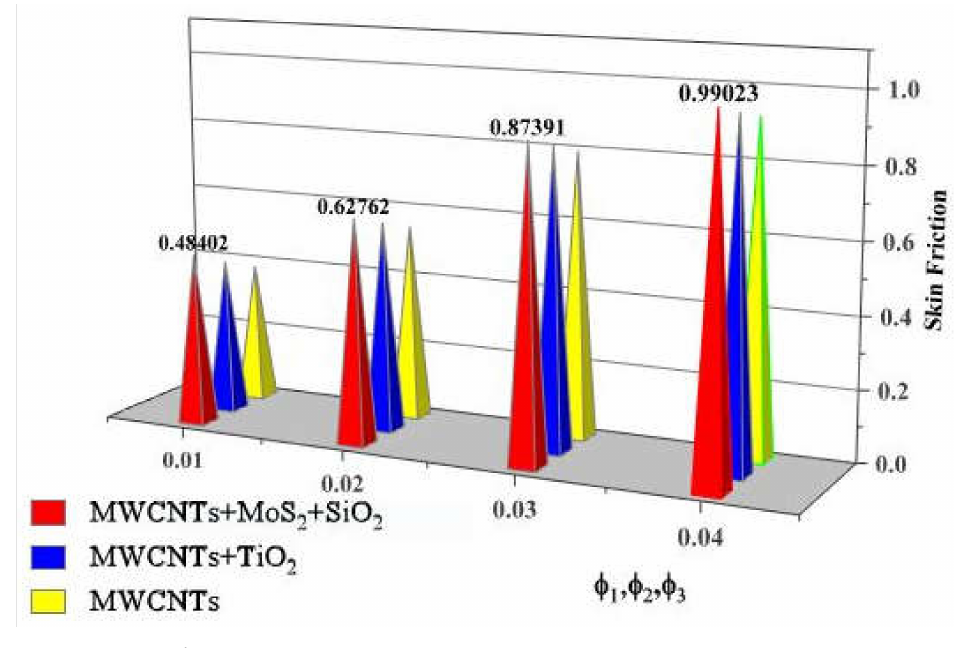
Figure 11. Drag force vs. φ 1 , φ 2 , φ 3 .